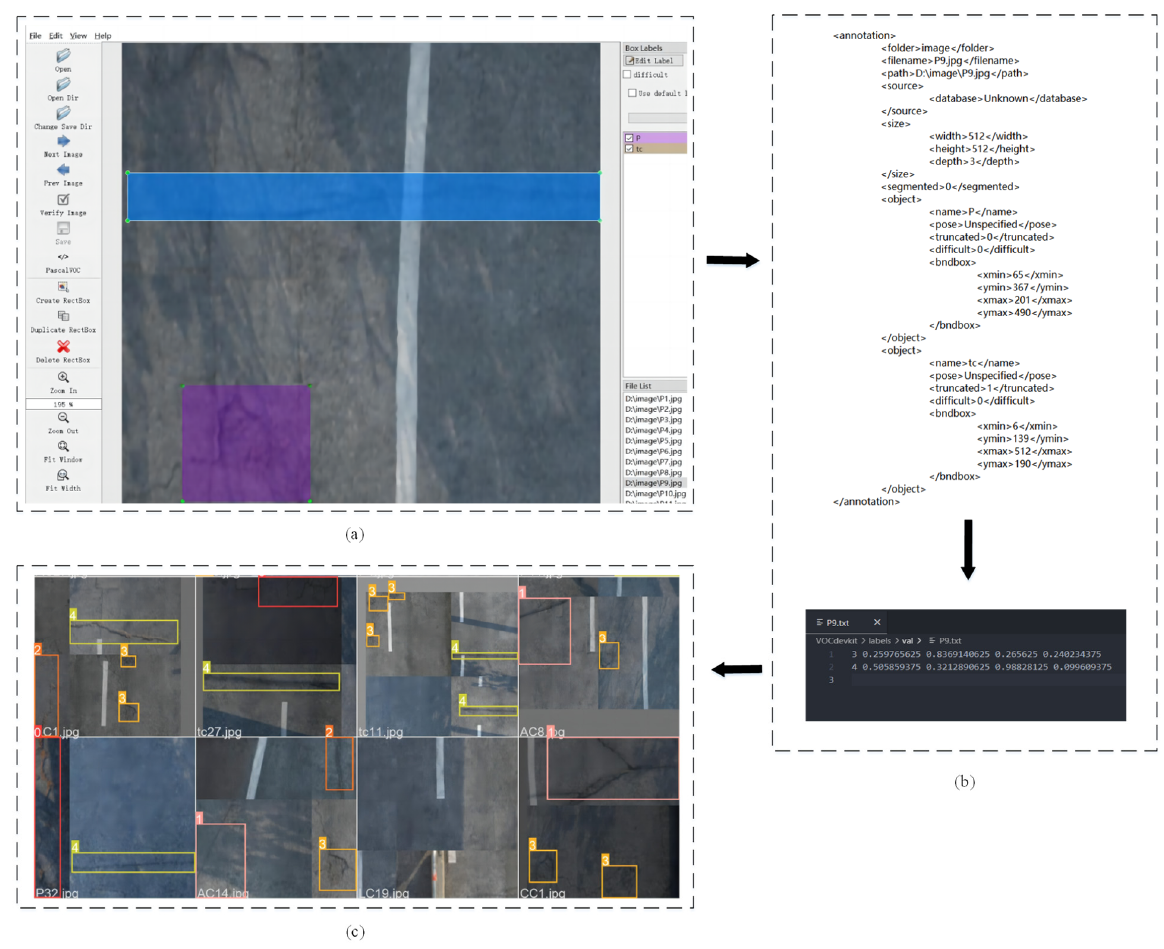
Figure 6. Images annotation process.( a ) Annotation by Labelimg. ( b ) Convert the XML file to a TXT file. ( c ) Training results visualization.